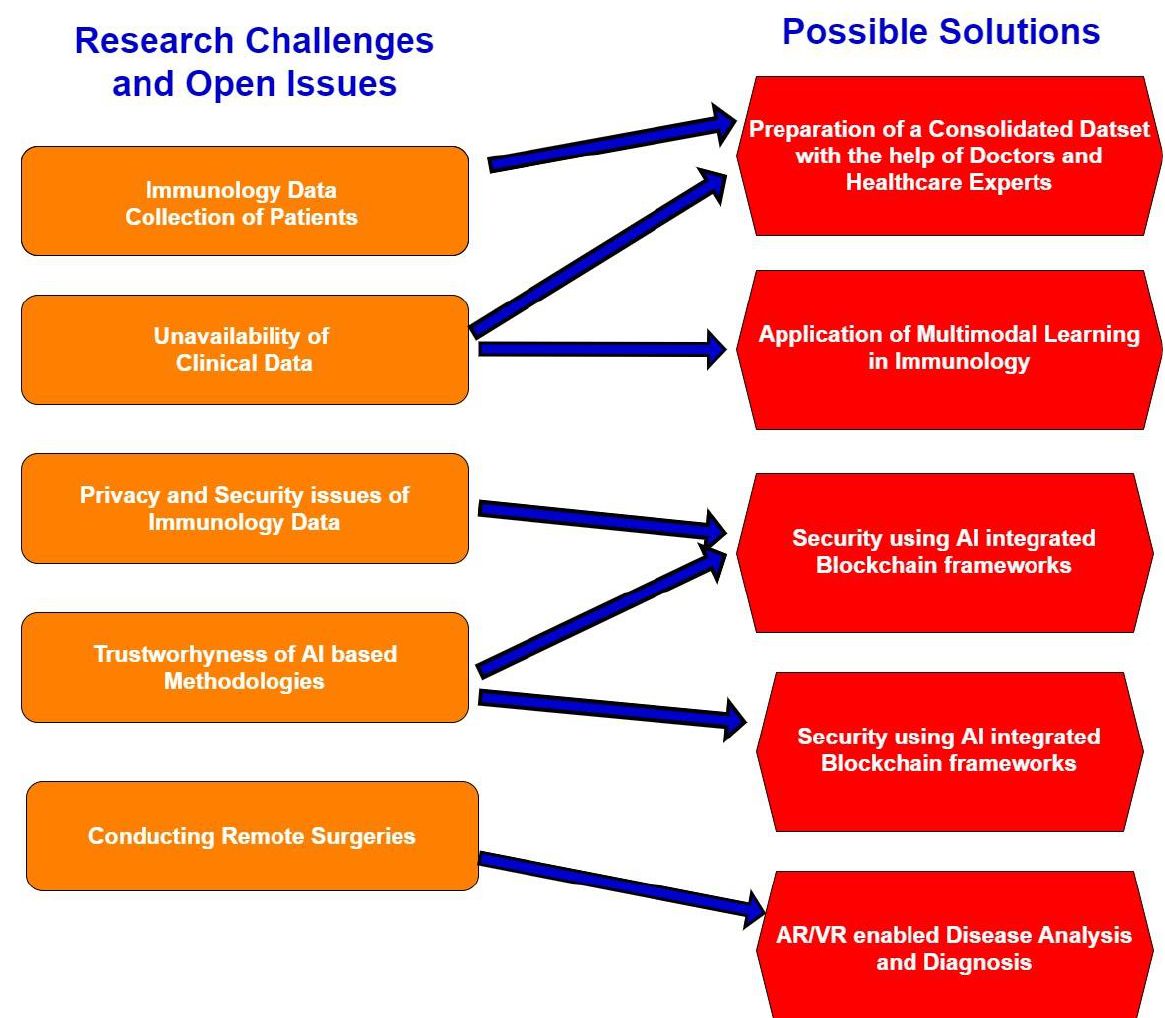
Figure 14. A logical mapping of Research Challenges, Open Research Issues, and Possible Solutions.